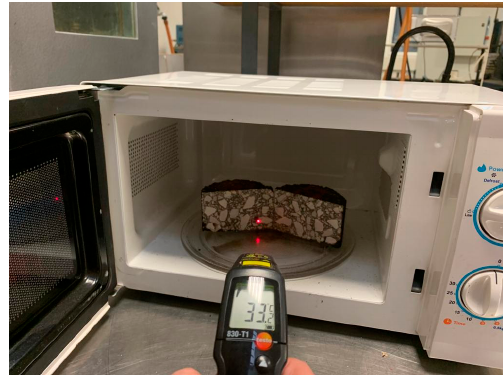
Figure 4. Internal temperature measurement.